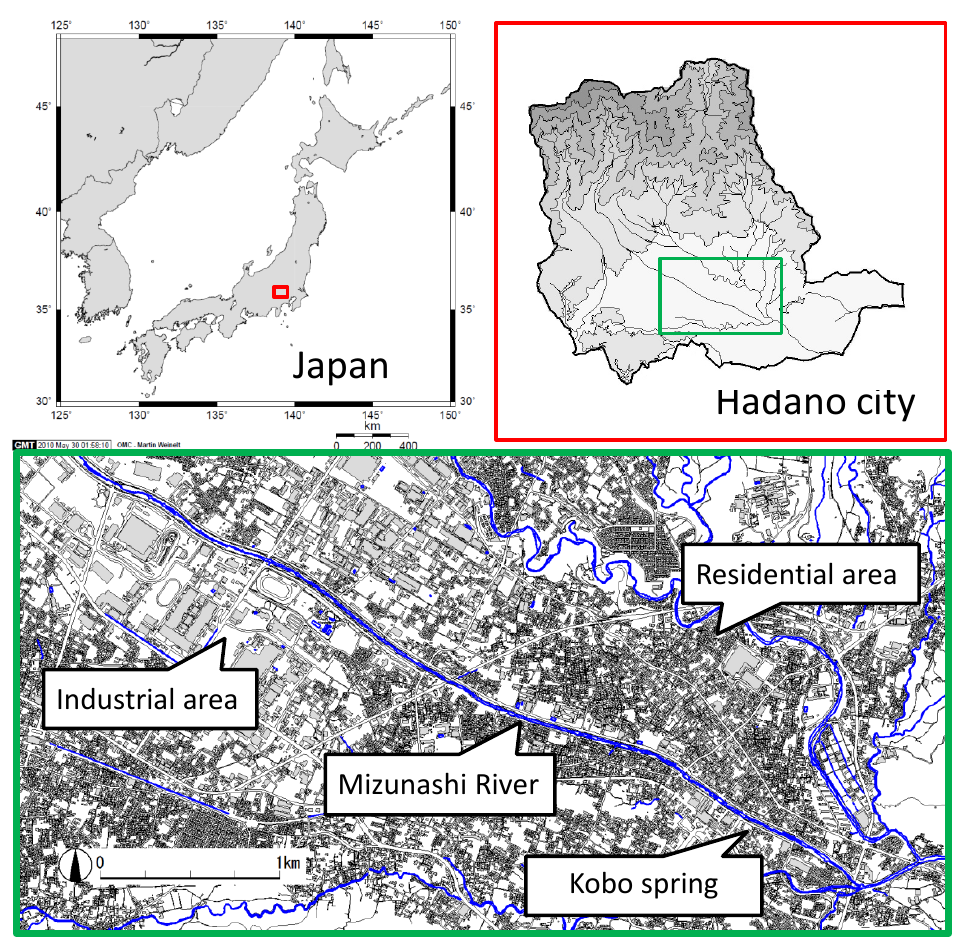
Figure 1. The location of Hadano.